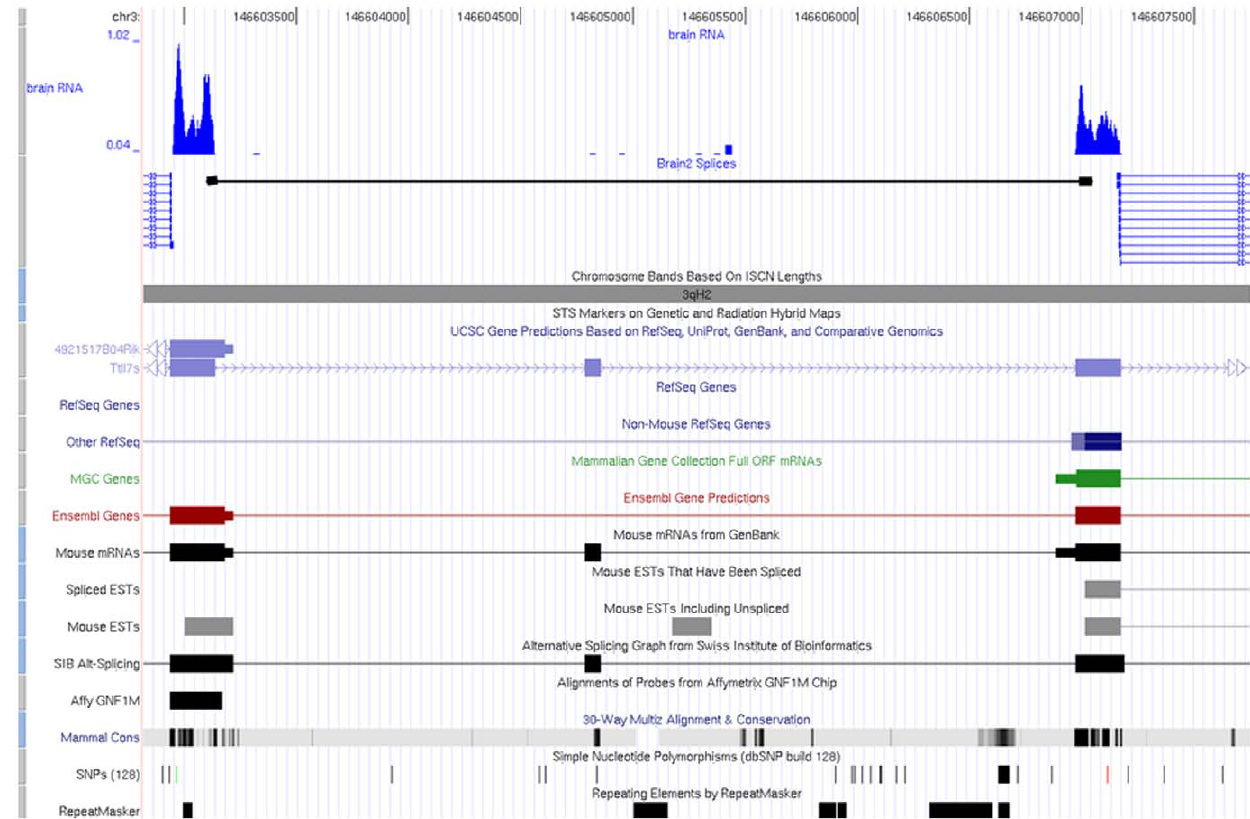
Figure 6. Example of novel splicing event identified by SAW from multiple reads in gene Ttll7s. The splicing events (annotated by black reads) are not identified by [11] based on UCSC mm9 gene models.